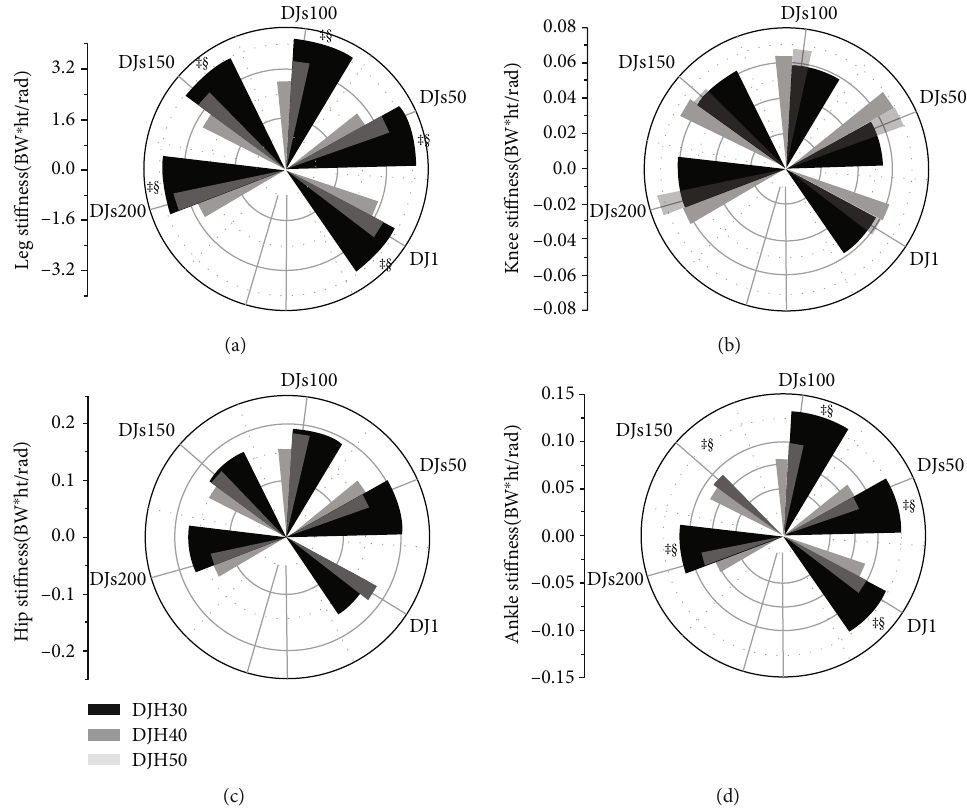
Figure 3: The right leg, hip, knee, and ankle sti ff ness during drop jumps from three heights at DJ1, DJs50, DJs100, DJs150, and DJs200. Asterisk † indicates that a signi fi cant di ff erence with DJH30; ‡ indicates that a signi fi cant di ff erence with DJH40; § indicates that a signi fi cant di ff erence with DJH50. p values < 0.05 were considered to signi fi cantly di ff